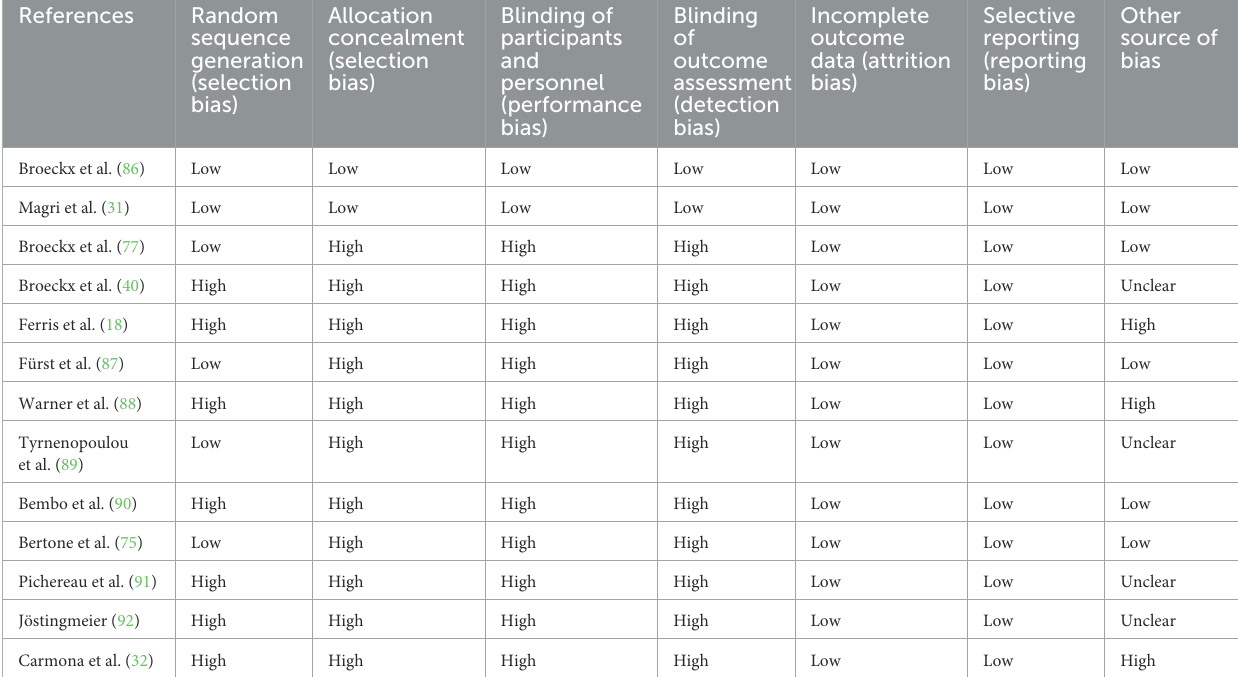
TABLE 2 Studies included in the systematic review demonstrating different source of